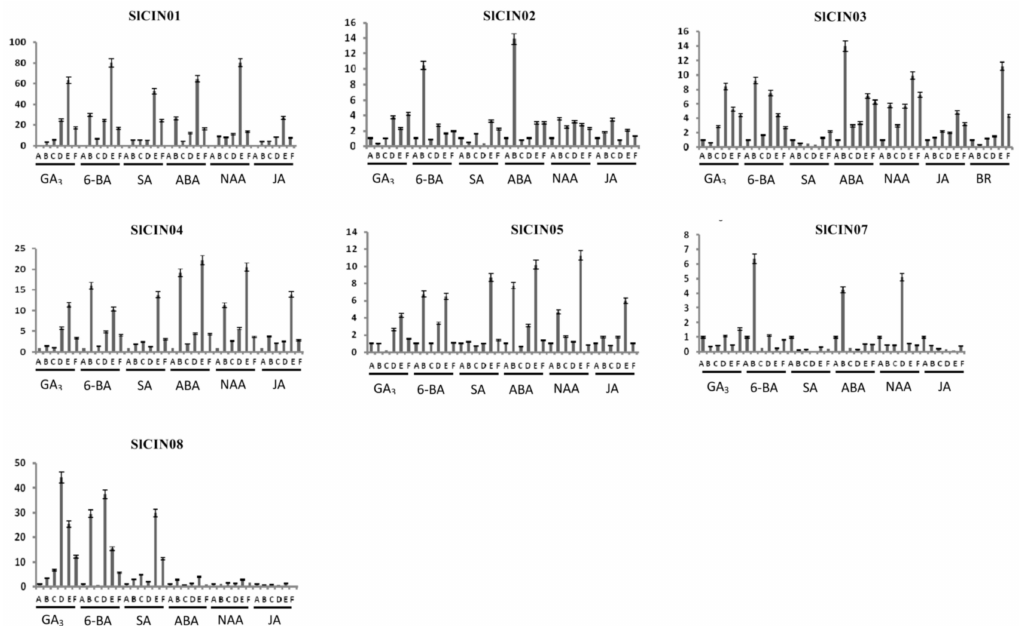
Figure 10. Expression profiles of tomato CIN genes in response to phytohormone treatments. Expression levels of these CINs under various phytohormone treatments were detected using qRT-PCR. Bar graphs indicate relative expression values of each CIN gene after phytohormone treatment. Leaf samples were collected at 0, 1.5, 3, 6, 12 and 24 h after treatment, respectively. Each time point of sample collection represented by A, B, C, D, E, and F, respectively. The mean of three biological replicates was selected for analysis.